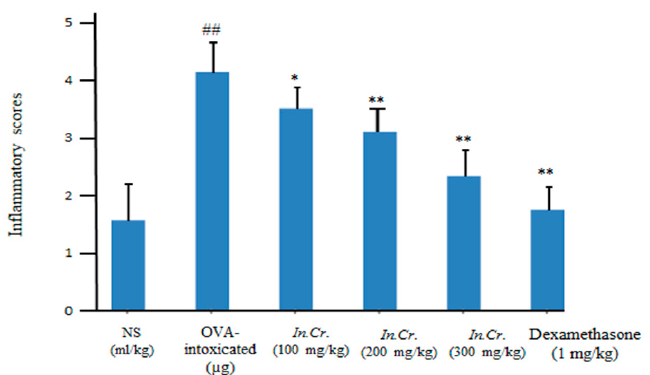
Figure 8. Significant reduction ( p < 0.05) of In.Cr for inflammatory marks at 100 mg/kg, instead ( p < 0.01) at 200 mg/kg in addition to 300 mg/kg. The model group displayed significant escalation in inflammation. ## p < 0.05 and ** p < 0.05 are significant while * p < 0.01 is more significant ( n = 8).